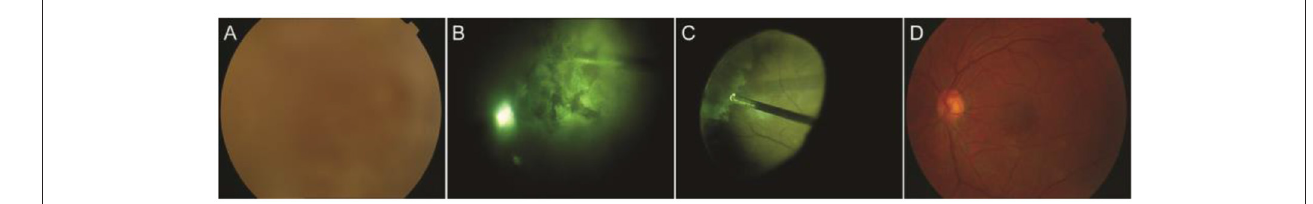
FIGURE 2 | Images of the funds and the first operation. (A) Color fundus image was very blurred before vitrectomy in the left eye; (B) Fibrillary and stiff vitreous opaque in the right eye; (C) As much of peripheral vitreous was removed as possible; (D) Normal fundus in the left eye 1 week after